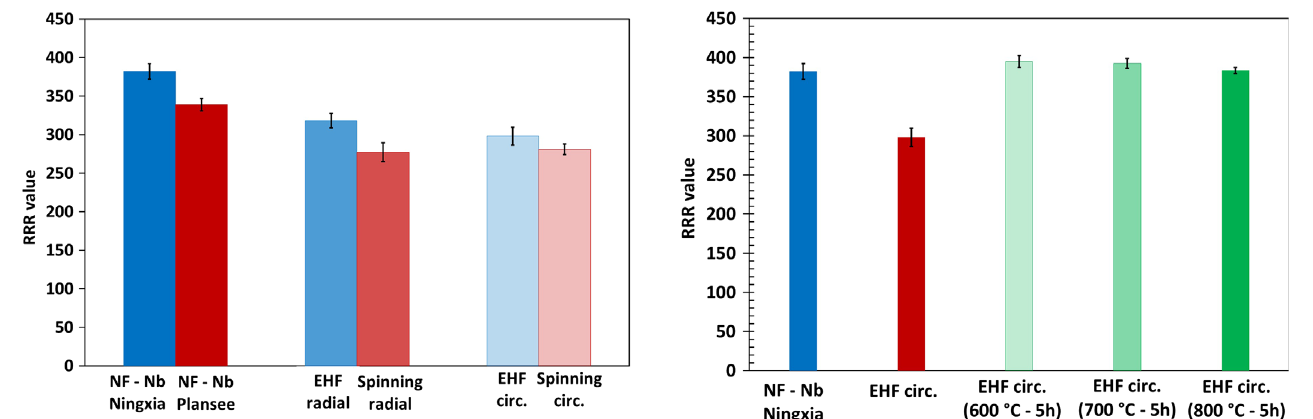
FIG. 13. RRR values after heat treatment at different temper- atures for 5 h for specimens obtained in circumferential direction (circ.) for a half-cell formed by EHF.